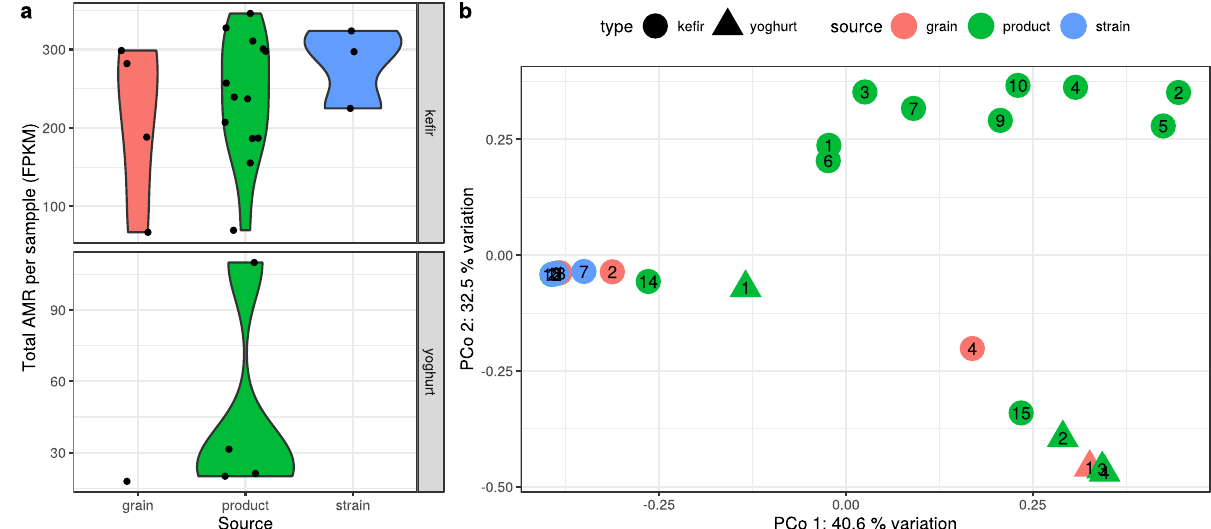
Figure 2. Antimicrobial resistance (AMR) abundance of the samples. ( a ) Violin plot representing the distribution of the total AMR fragments per kilobase per million fragments (FPKM) per sample, grouped by type and source. The horizontally jittered dots represent the FPKM of the samples. ( b ) The AMR abundance diversity ( β -diversity) of the samples. It is plotted on the first two axes of principal coordinate analysis (PCoA) performed on Bray-Curtis distance which was calculated using the relative abundances of contigs harbouring ARGs. The symbols show the type, the colours the source, while the numbers correspond to the sequence number in the Sample ID. Some samples (k_s_01, k_s_04, k_s_05, k_s_06, k_p_08) are not shown as their ORFs did not meet filtering